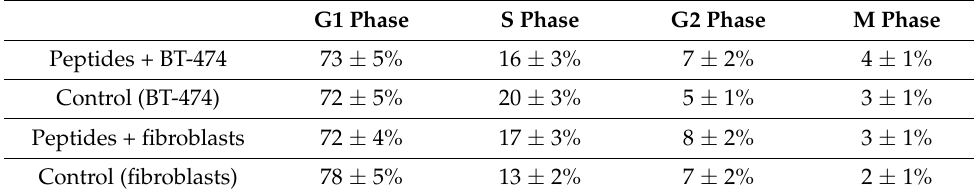
Table 1. Results of cell distribution by phases of the cell cycle after peptide treatment. G1 Phase S